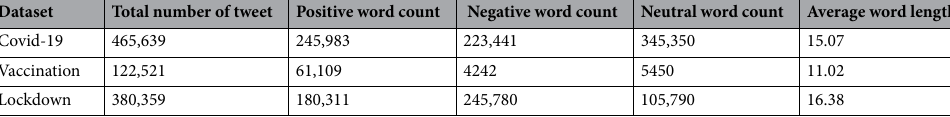
Table 4. Statistics of the collected